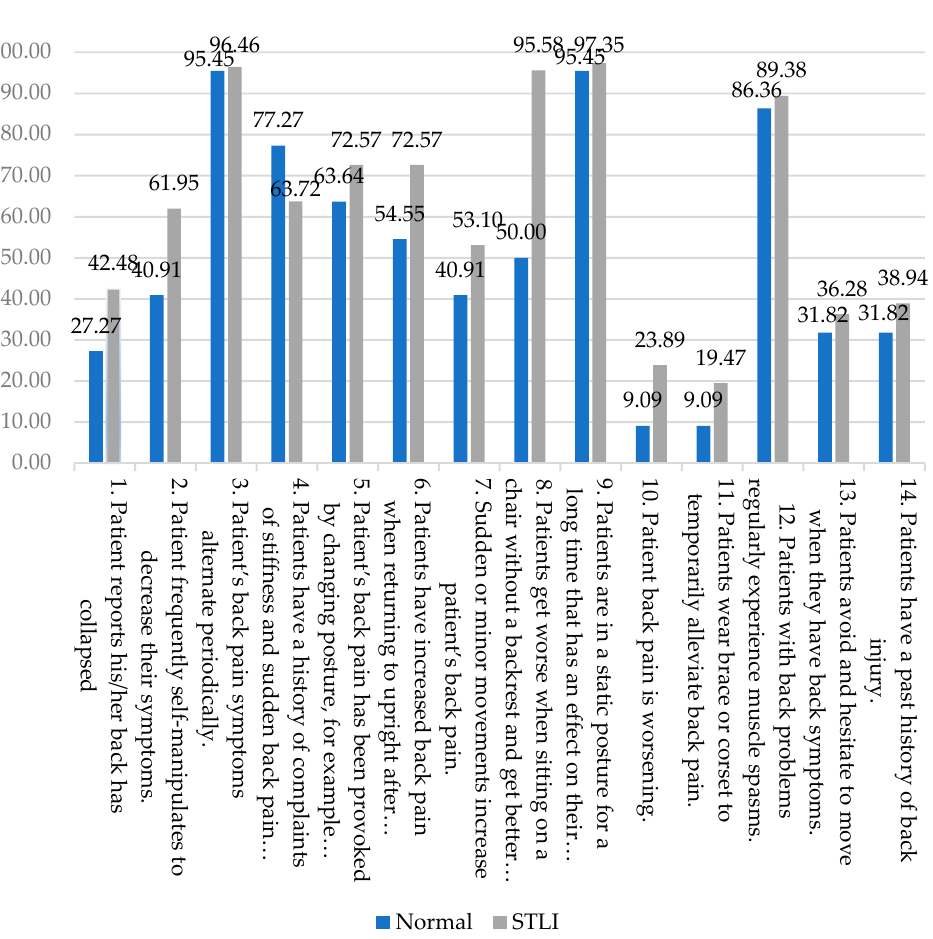
Figure 3. Comparison of the percentage of positive answers to the lumbar instability screening tool questions in chronic low back pain patients with and without the sub-threshold level of lumbar instability.